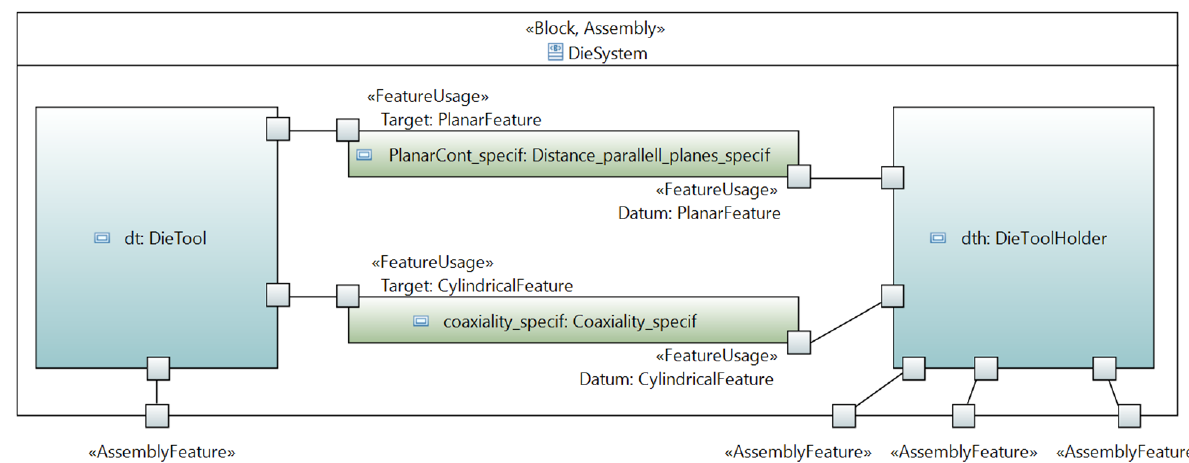
Figure 15. IBD to represent the Feature ‐ based internal structure of the DieSystem Block.